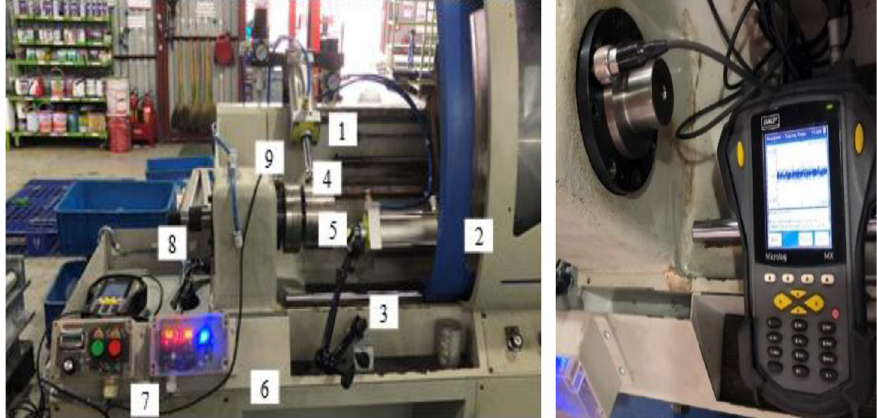
Fig. 3. The experimental apparatus. 1 – pneumatic cylinder generates a radial force; 2 – pneumatic cylinder generates an axial force; 3 – indicator; 4 – vibration sensor; 5 – spindle bearing; 6 – the temperature controller, 7 – spindle speed controller, 8 – vibration measurement and analysis equipment, 9 – pneumatic cooling lines.